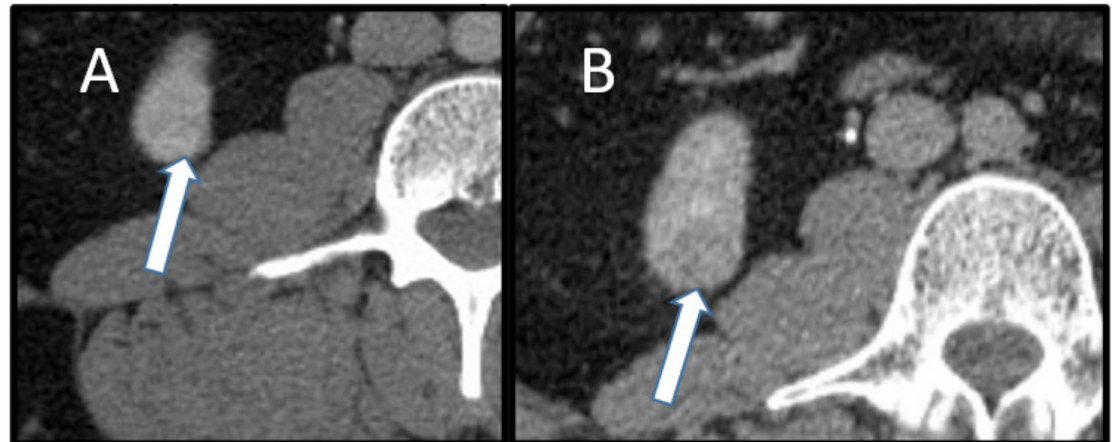
Figure 9. A 39-year-old man with a history of Cowden syndrome, follicular thyroid cancer, and lung cancer. Axial contrast- enhanced computed tomography demonstrates ( A ) corticomedullary phase with subtly enhancing 1.9 cm lesion (arrow) in the inferior right kidney, and ( B ) delayed imaging shows washout (arrow). This was pathologically proven to represent clear cell renal carcinoma. An additional 1.6 cm biopsy-proven clear cell renal cell carcinoma with the same imaging features was present in the superior pole left